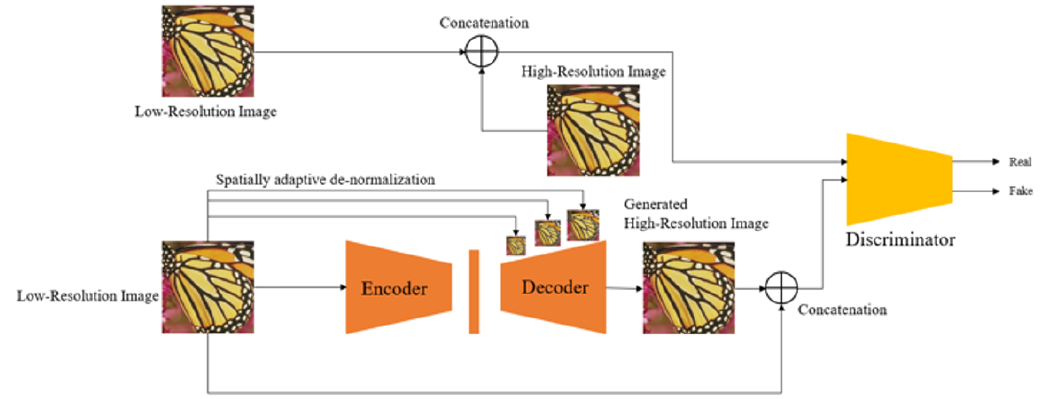
Figure 7. The overall structure of single image super-resolution via spatially adaptive denormaliza- tion: The proposed SPADE-GAN structure is differentiated from ordinary super-resolution methods in the decoder because it uses hierarchical image inputs to obtain feature maps. With this new method, the discriminator D compares the fake image and the real